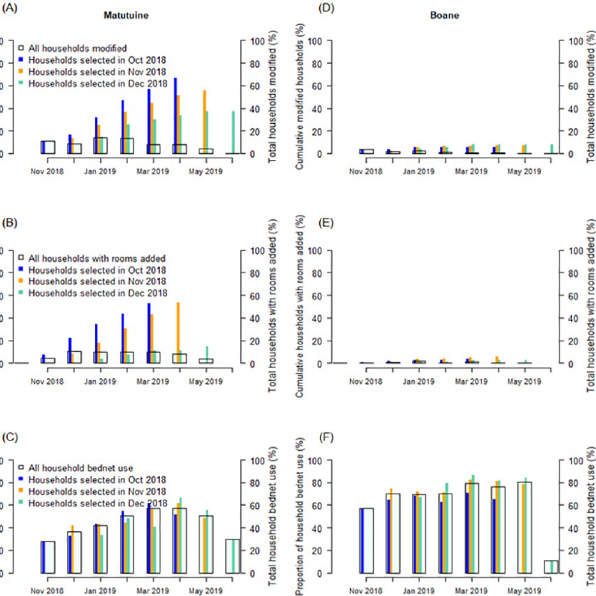
Fig 4. Summary of household modifications post spraying (Number of households assessed monthly are provided in Table 1). In each panel, the colour of the bar indicates the month when the households were first sprayed and recruited to the trial; (October, blue), November (orange), and December (green). The overlaid square with black outline shows the average proportion of households modified ( A and D ), rooms added on the compound ( B and E ), and mosquito net use ( C and F ) for each month during the follow-up. This allows us to determine that e.g. in Matutuine, most household modifications took place in January-February and the peak modification took place from November through February. The accumulation of households with walls modified fully or partly by either painting, washing, or scrubbing over time (wall modification) in ( A ) Matutuine district, and ( D ) Boane district; The accumulation of households with rooms or compartment added on the compound in ( C ) Matutuine district and ( F ) Boane district. Mosquito net use in ( B ) Matutuine district and ( E ) Boane district.